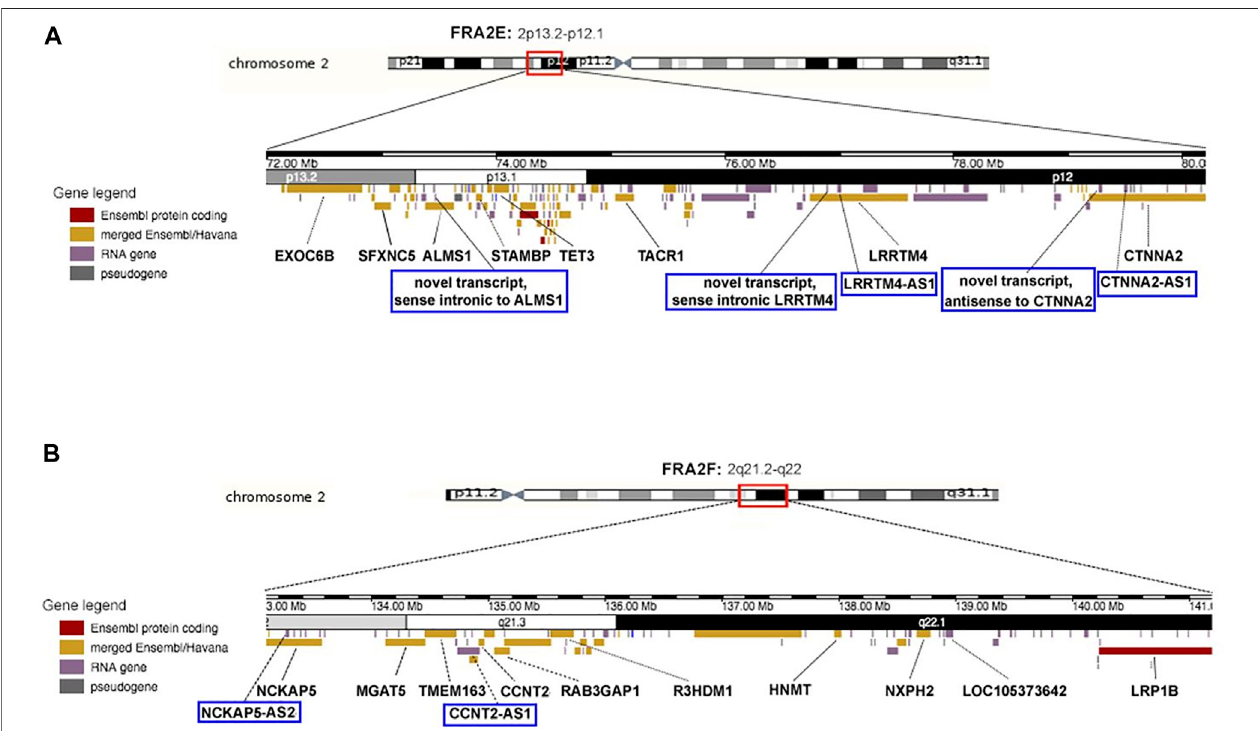
FIGURE 6 | Schematic representation of the most expressed fragile sites in glioblastoma cells: FRA2E (2p13/p12) (A) and FRA2F (2q22) (B) . In every ideogram, only the genes that are primarily expressed in the brain are indicated. Colors correspond to different genes localized in these speci fi c regions (delimitated by the red brackets). Highlighted genes in blue brackets are the antisense RNAs (asRNAs) and intronic RNAs